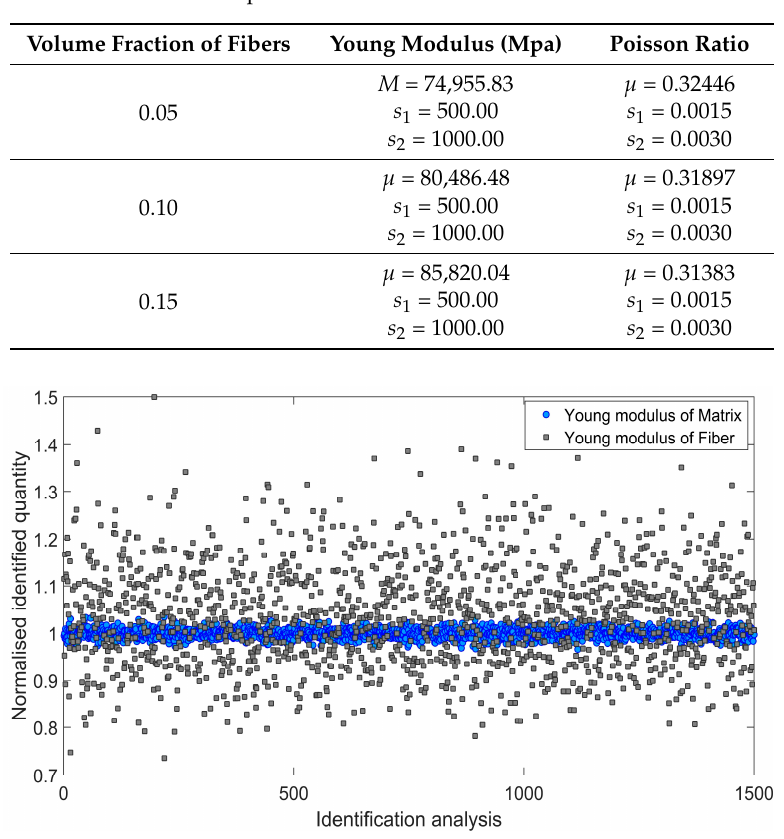
Figure 6. Normalized Young modulus of matrix and fiber identified during 1500 independent simulations involving standard deviation s 1 .